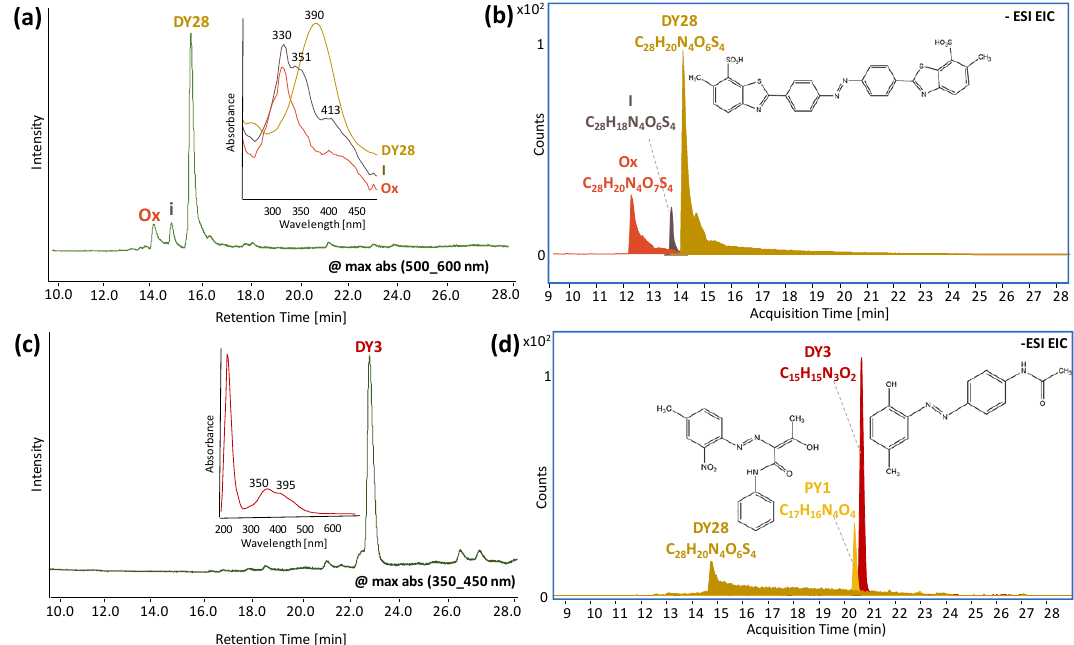
Figure 5. Sample T: ( a ) High Performance Liquid Chromatography with Diode Array Detector (HPLC–DAD) chromatogram acquired at max abs. 500–600 nm together with the UV–Vis spectrum of DY28, I, and Ox and ( b ) High Performance Liquid Chromatography with mass spectrometry detection (HPLC–ESI–MS) Extracted Ion Chromatograms (EIC) of C 28 H 20 N 4 O 7 S 4 , C 28 H 18 N 4 O 6 S 4 , and C 28 H 20 N 4 O 6 S 4 (negative ionization mode). Sample P: ( c ) HPLC–DAD chromatogram acquired at max abs. 350–450 nm together with the UV–Vis spectrum of DY3 and ( d ) HPLC-ESI-Q-ToF EIC of C 28 H 20 N 4 O 6 S 4 , C 17 H 16 N 4 O 4 , and C 15 H 15 N 3 O 2 (negative ionization